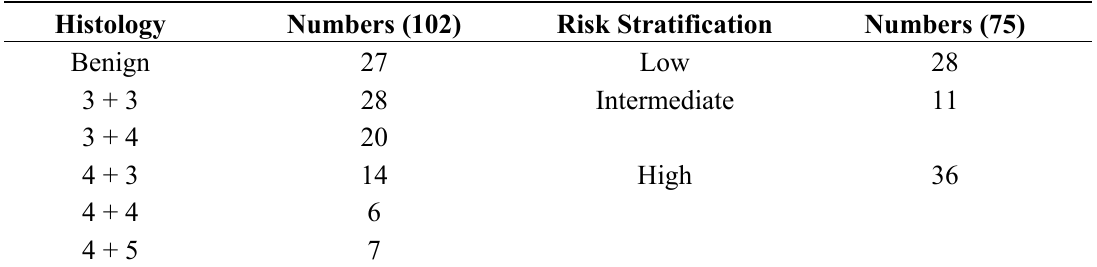
Table 3. Histology, D’Amico risk stratification and dysregulated